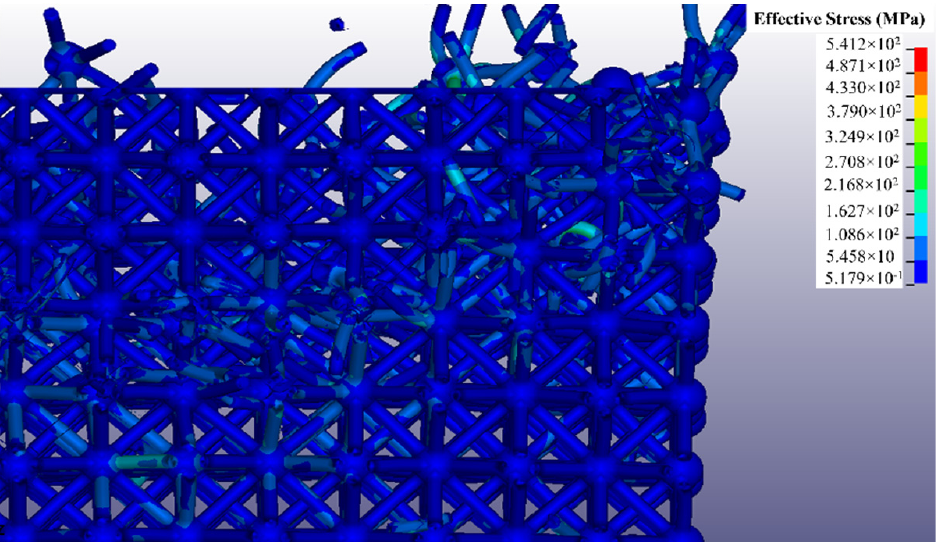
Figure 20. Cross section of the octet truss block sectioned from the center.